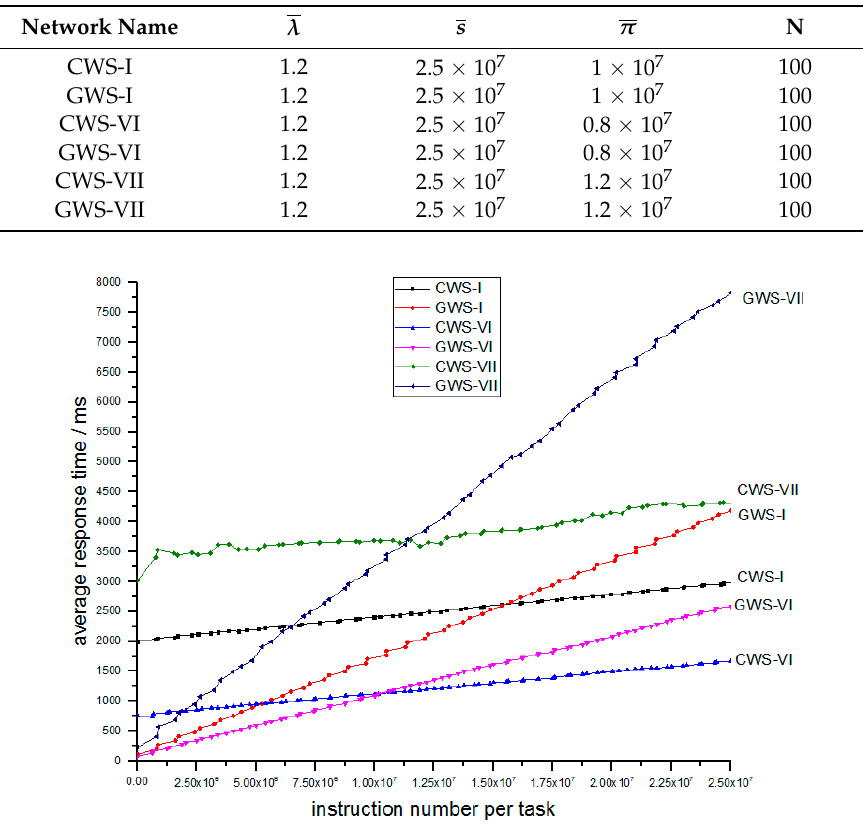
Figure 13. The relation of average response time and number of instructions per task between different average instruction number per task.